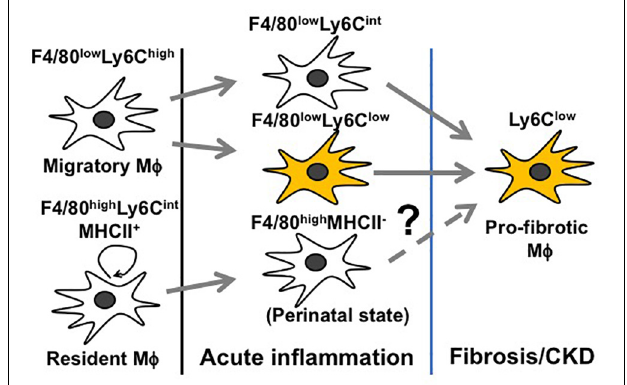
FIGURE 4 | Schematic representation of M φ subtypes throughout different stages of